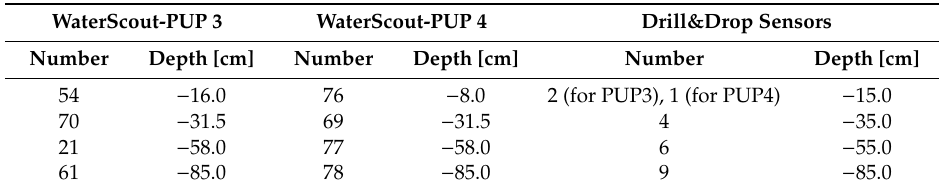
Table 1. Sensors tested in the field.